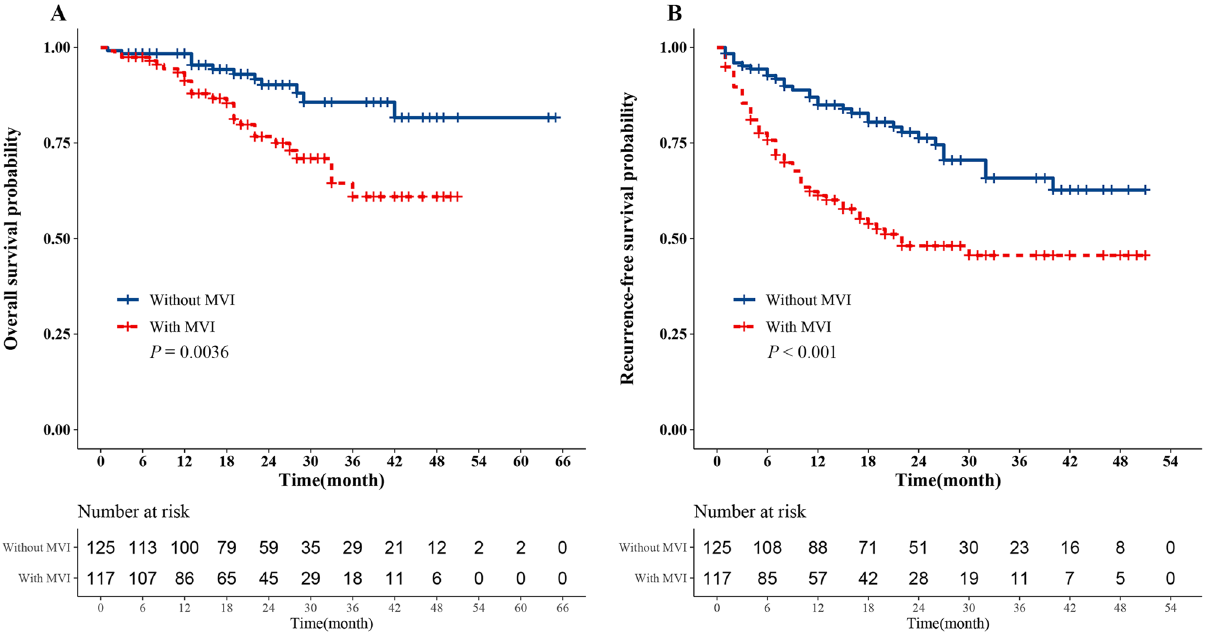
Figure 1. Kaplan–Meier survival curves analysis of histologic MVI in HCC. ( A ) Overall survival analysis ( P = 0.0036). ( B ) Recurrence-free survival analysis ( P <